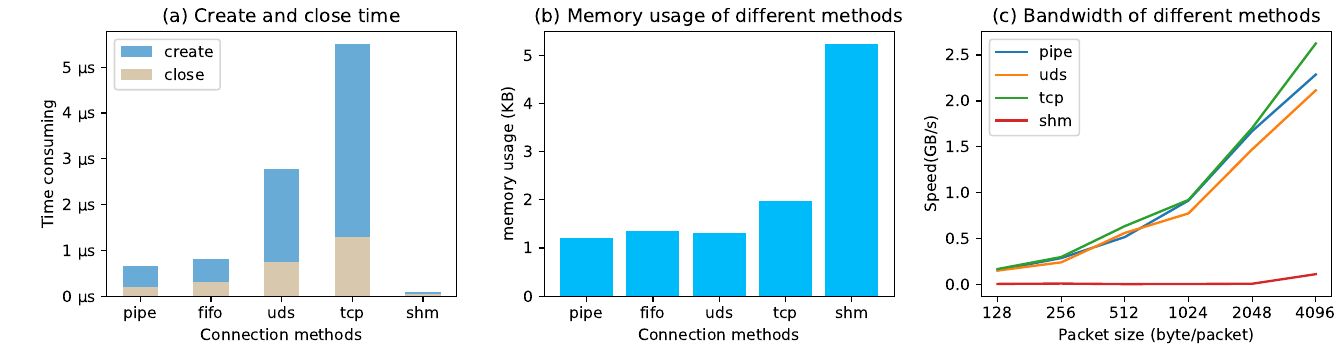
Figure 10. Performance comparison of various simulation link implementation